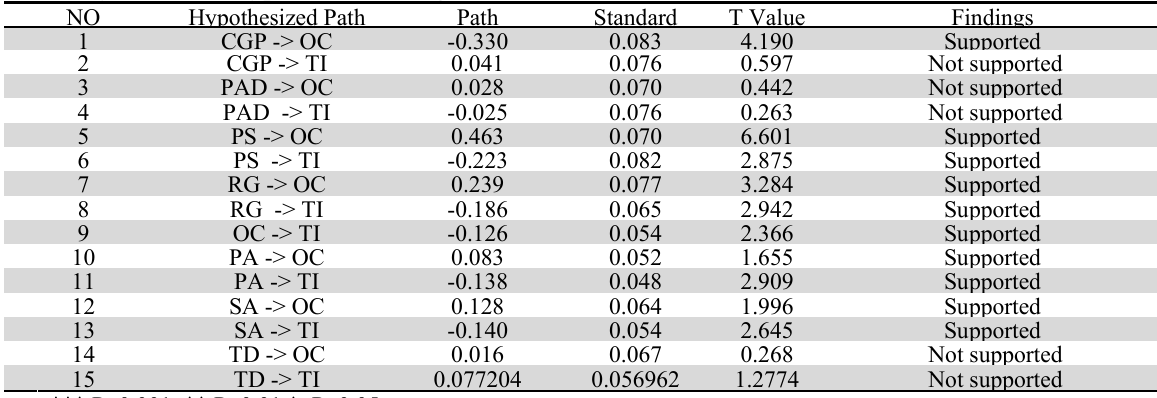
Summary of Direct Hypothesis